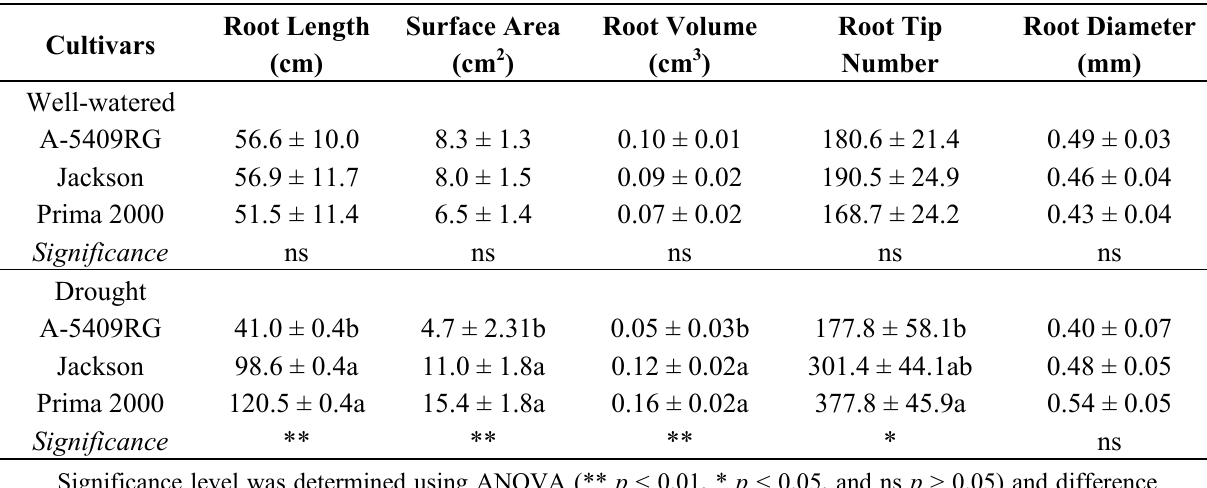
Table 2. A comparison of root morphology traits in three soybean cultivars (A5409RG, Jackson and Prima 2000) under well-watered conditions and